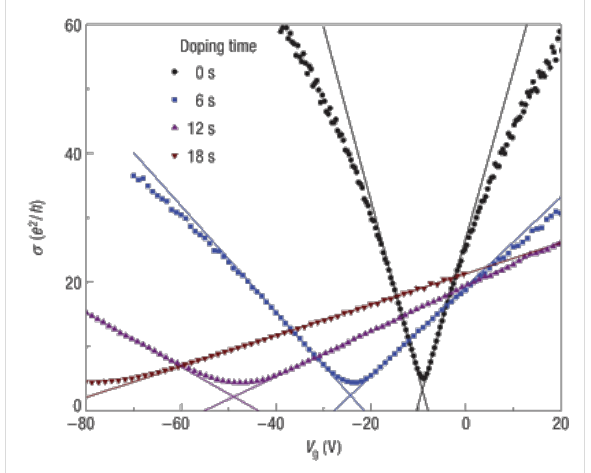
Figure 2: Conductivity as a function of the gate voltage ( σ ( V g )) of graphene at different exposures to K. The shift of neutrality point to negative gate voltages indicates an increase of n-type doping with increasing exposure to K atoms. The change in the slope of the curves suggest a reduction of the mobility of the charge carriers. Reprinted with permission from [29]. Copyright 2008 Nature Publishing